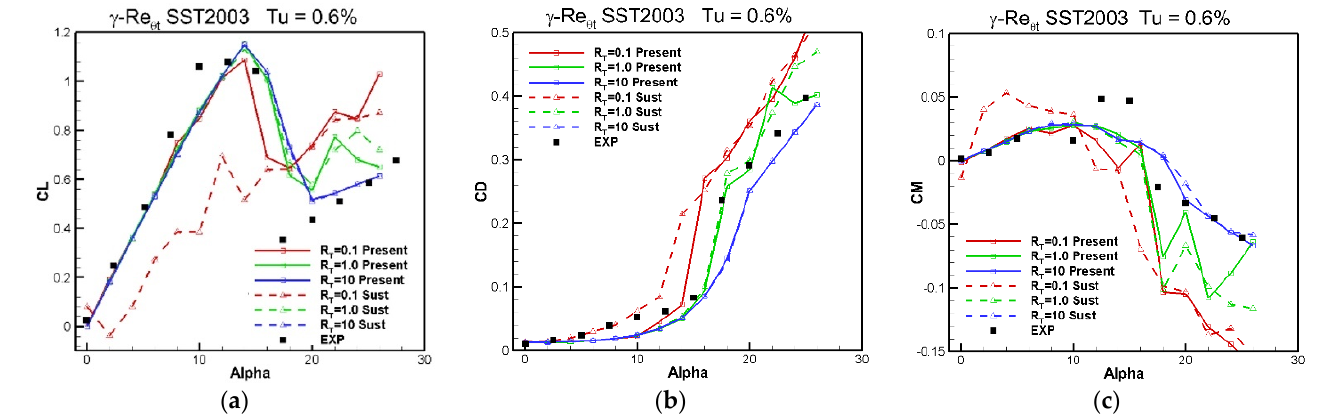
Figure 6. Computed force coefficients predicted with sustaining term from [4] and present approach using γ -Re θ t SST 2003 model. ( a ) Lift coefficient vs. AoA. ( b ) Drag coefficient vs. AoA. ( c ) Pitching moment coefficient vs. AoA.